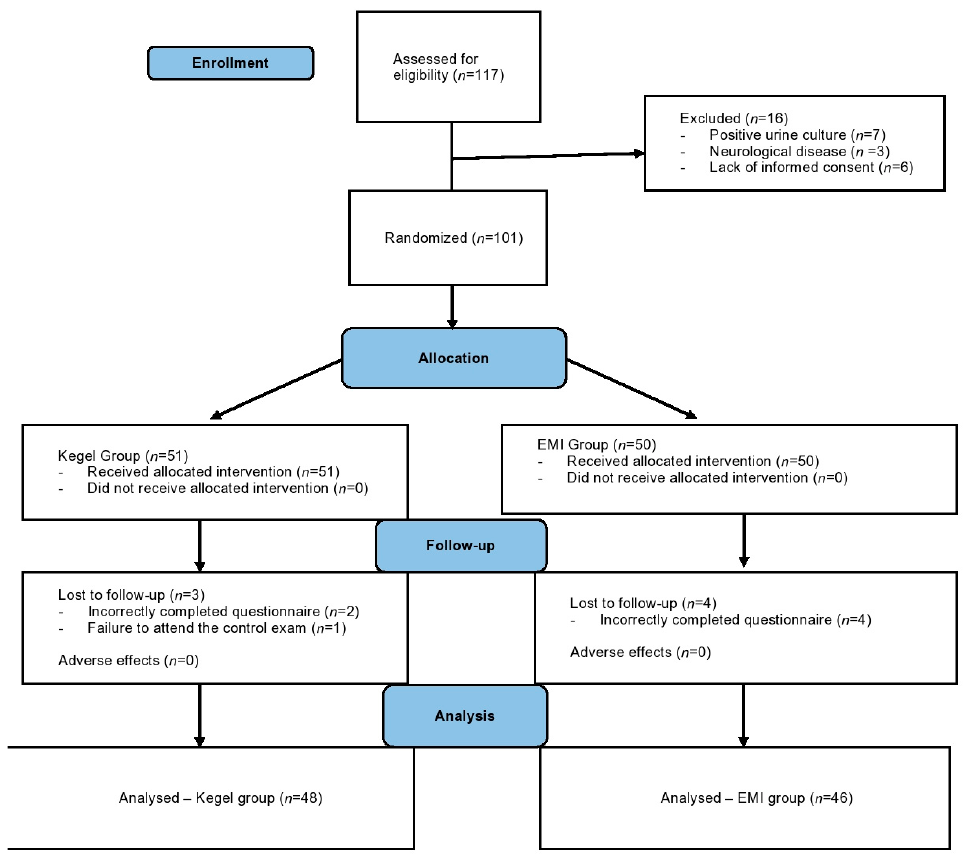
Figure 1. Study flow diagram according to CONSORT guidelines. Note: EMI group = extracorporeal magnetic innervation group.